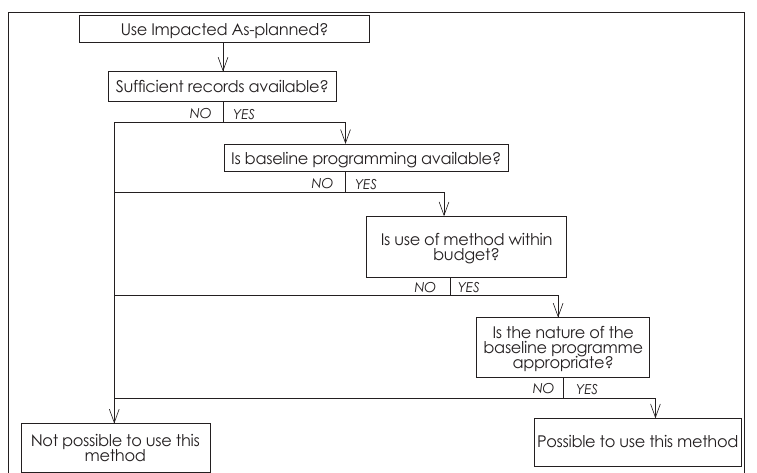
Use Impacted As-planned?